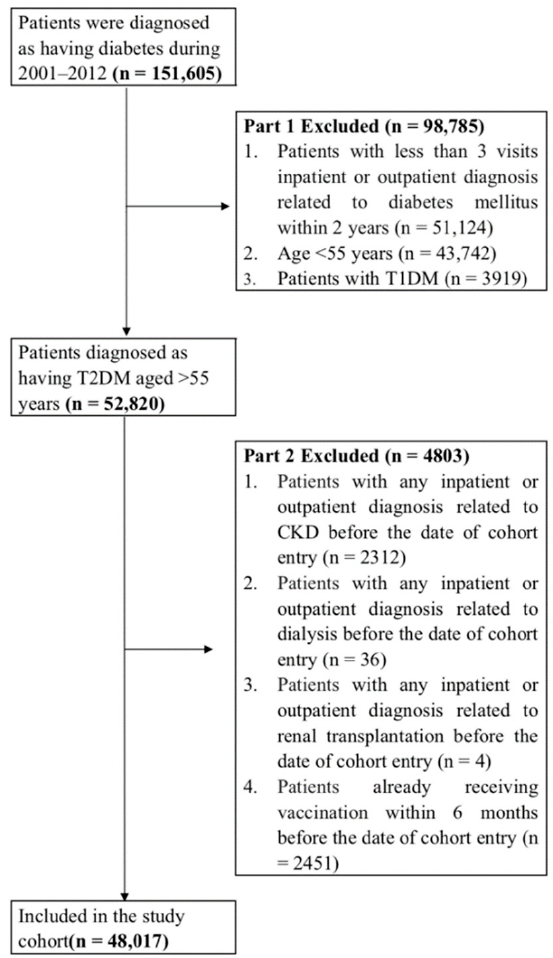
Figure 1. Data Selection Process.